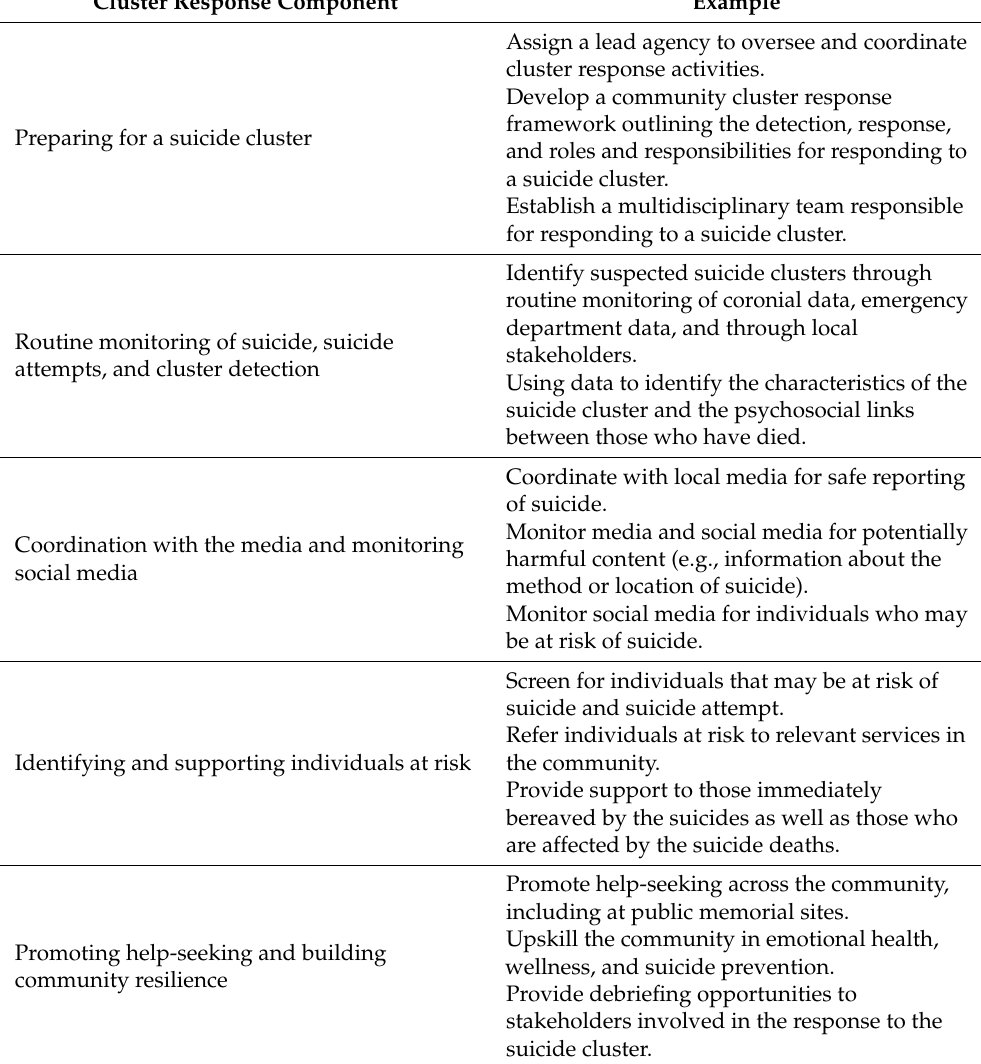
Table 1. Core components of cluster response